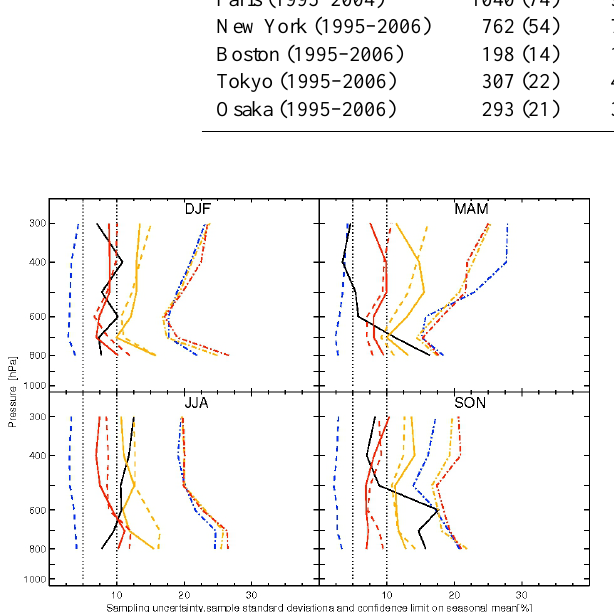
Fig. 8. Same analysis as in Fig. 5 (Frankfurt) but for